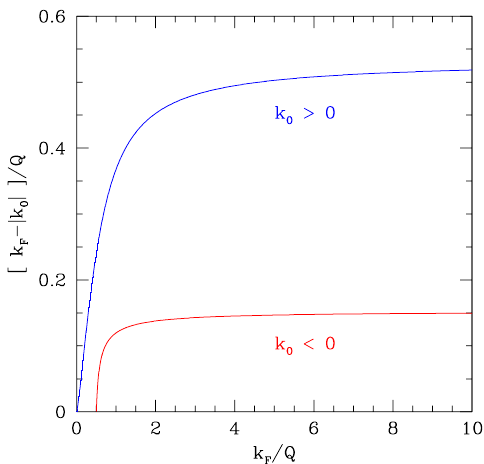
Figure 1. Boundaries in parameter space where the steady state solution allows for a single black-hole horizon. The regions below either curve identify a stationary state characterized by a supersonic transition. The blue line corresponds to a left moving fluid ( k 0 > 0) while the red line to a right moving fluid ( k 0 < 0).